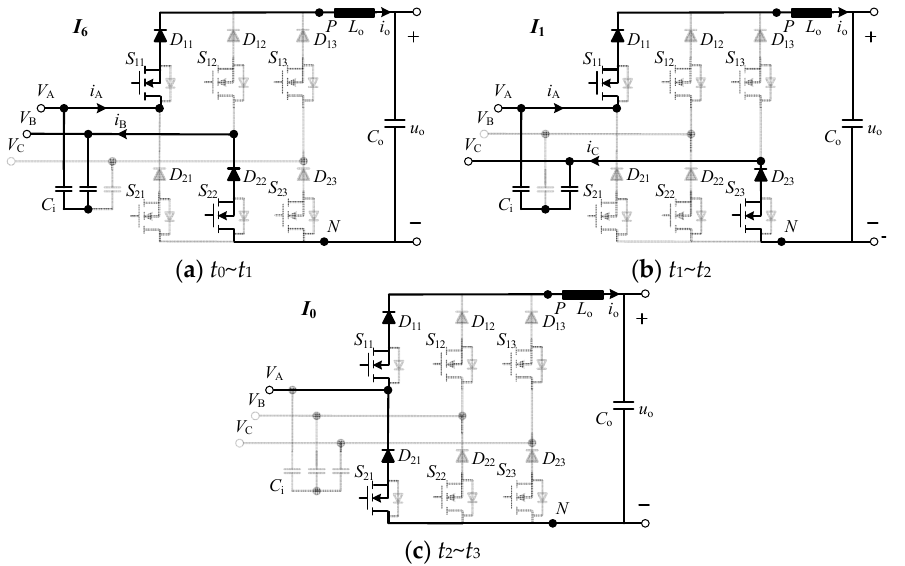
Figure 6. Switching states of the conventional CSR in sector 1. ( a ) Mode 1. ( b ) Mode 2. ( c ) Mode 3.